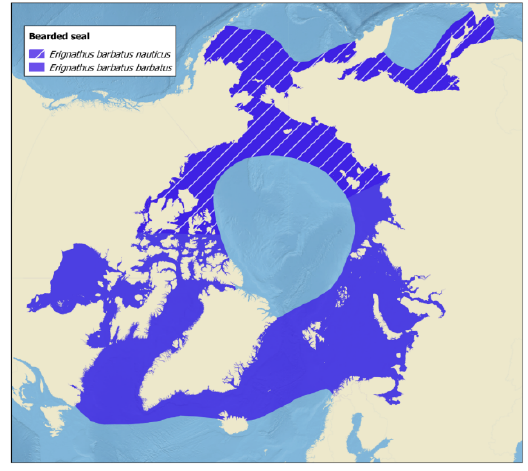
Figure 1. Distribution of E. b. barbatus and E. b. nauticus (NAMMCO website, Bearded Seal Species Page